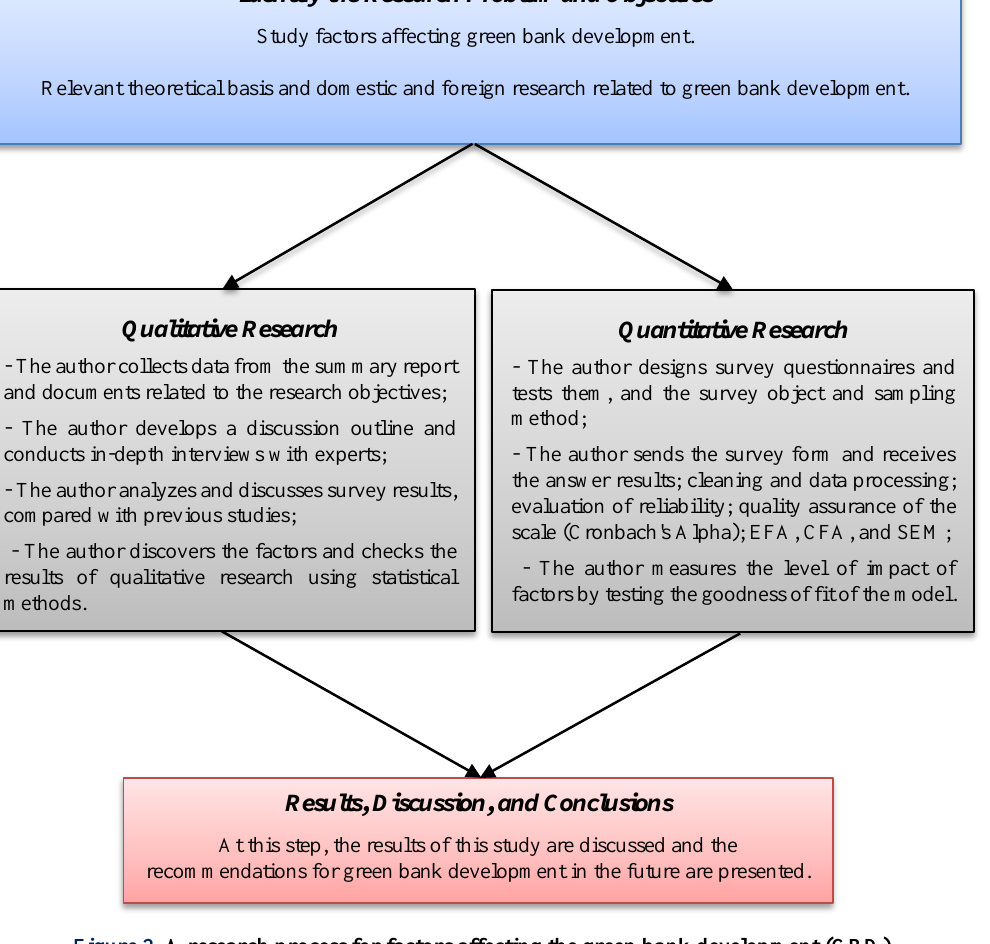
Figure 2. A research process for factors affecting the green bank development